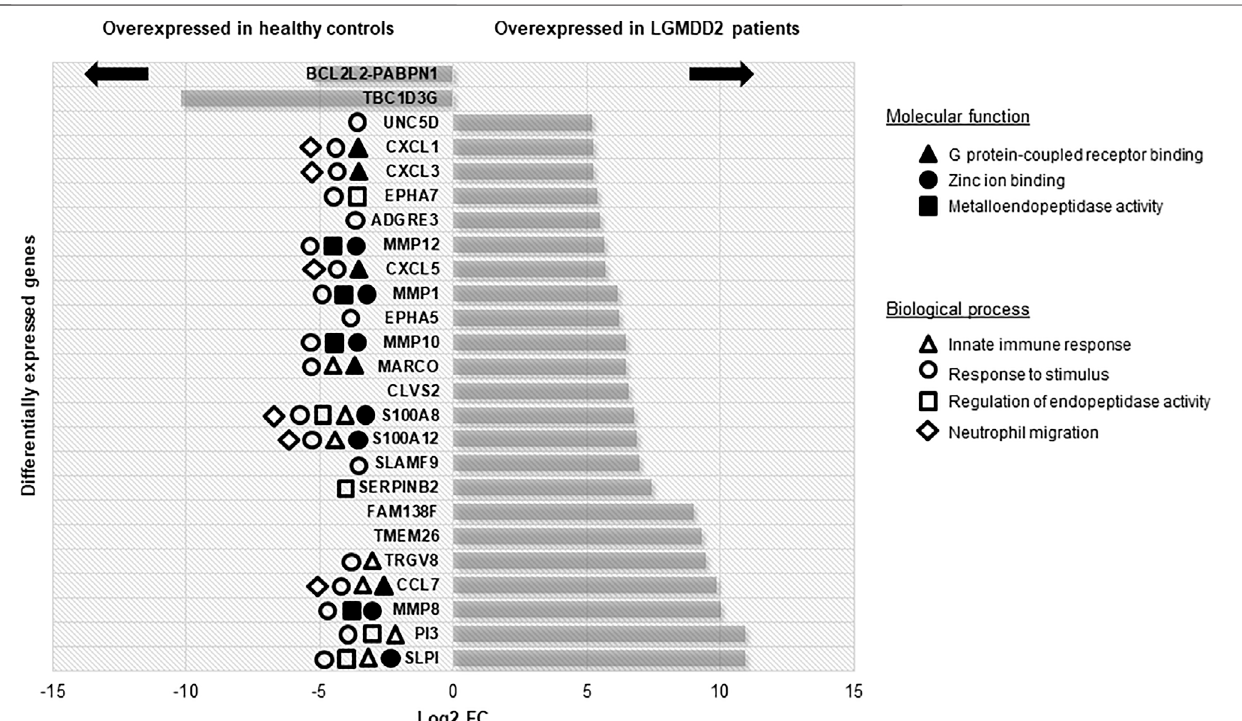
( Supplementary Table S1 ). Among the top 25 DE genes, we found an upregulation in LGMDD2 patients of several genes implicated in G protein-coupled receptor binding chemokines (CXCL1, CXCL3, CXCL5, and CCL7), zinc ion binding proteins (MMP1, MMP8, MMP10, MMP12, S100A8, and S100A12), and metallopeptidase activity